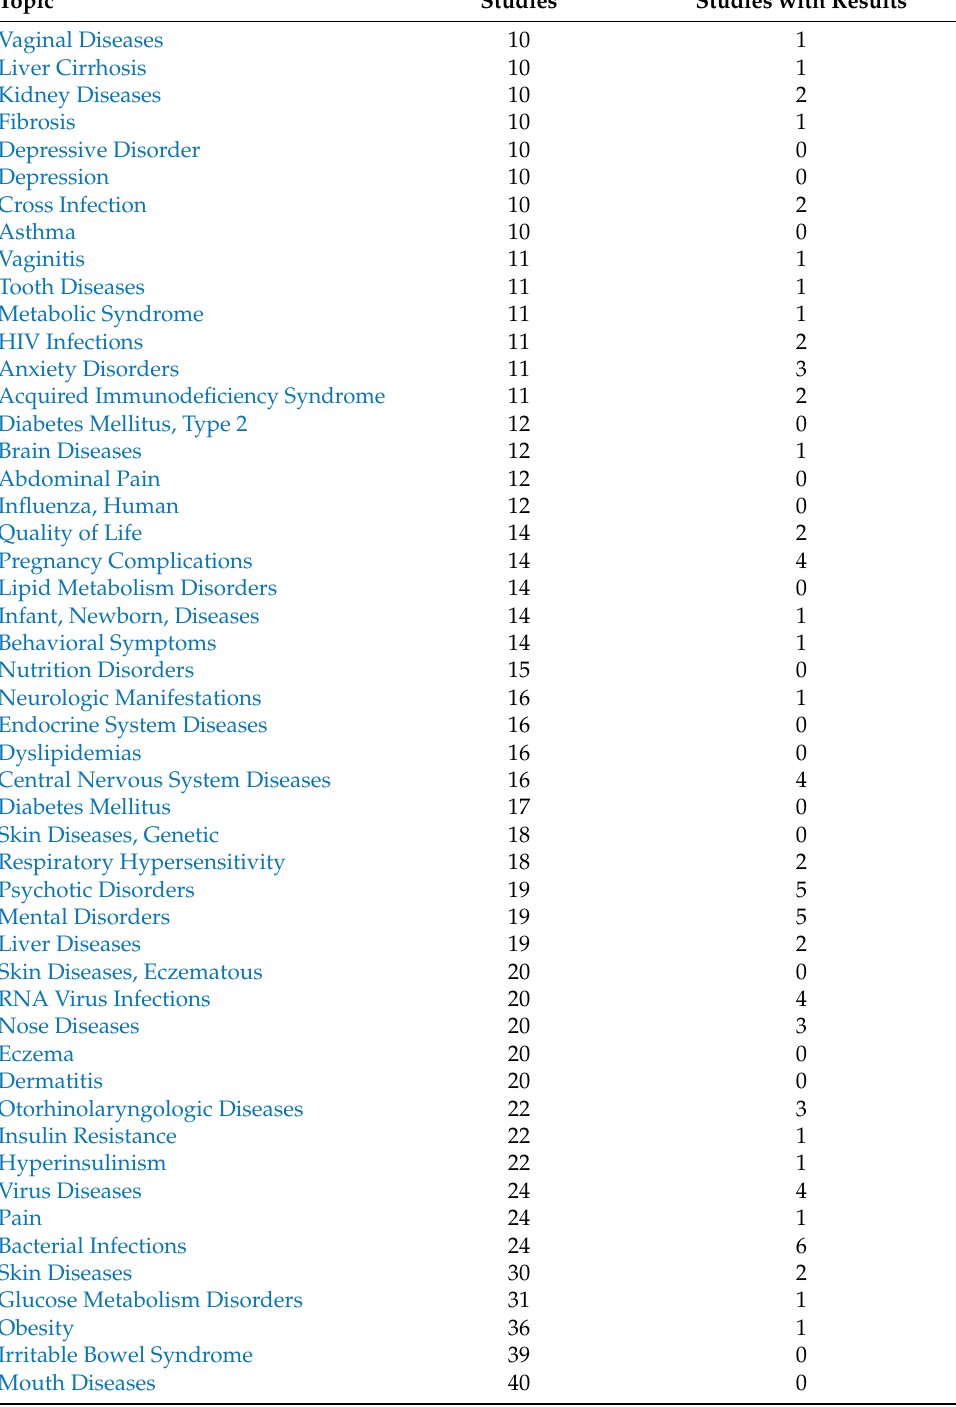
Table 1. Studies on probiotics found on ClinicalTrials.gov. The topic contains the link to the study. Topic Studies Studies with